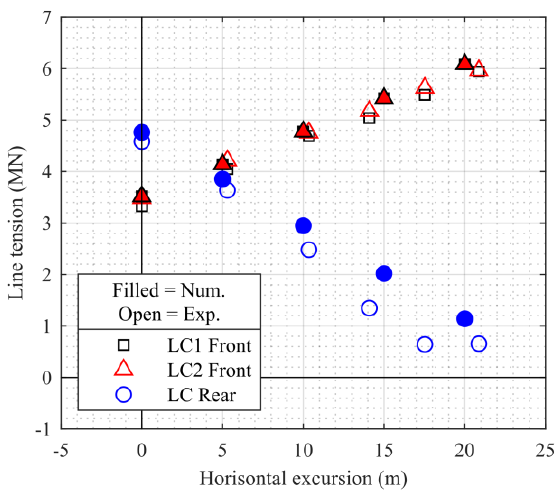
Figure 12. Comparison between numerical and experimental static stiffness test.